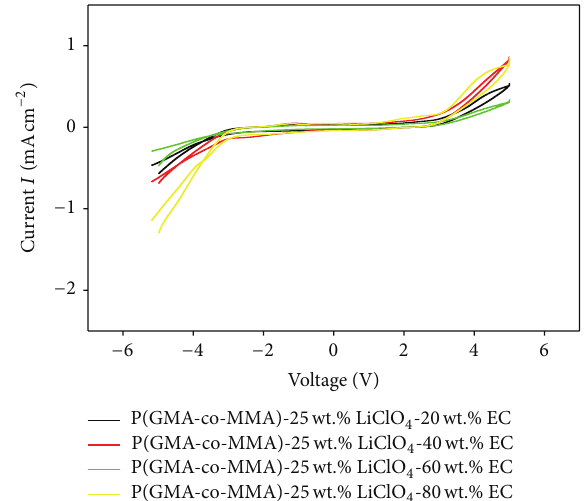
Figure 9: CV curves of P(GMA-co-MMA)-25 wt.% LiClO 4 based polymer electrolyte as a function of EC